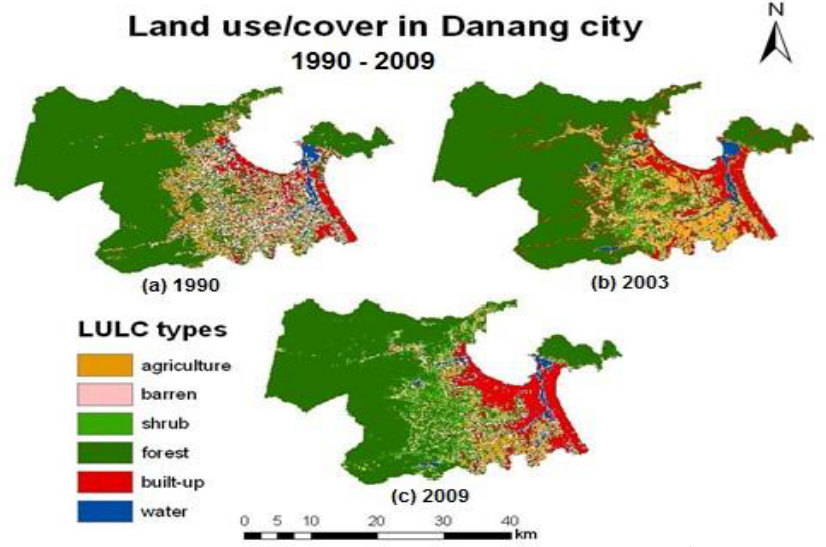
Figure 2. Land use/cover maps of Danang city